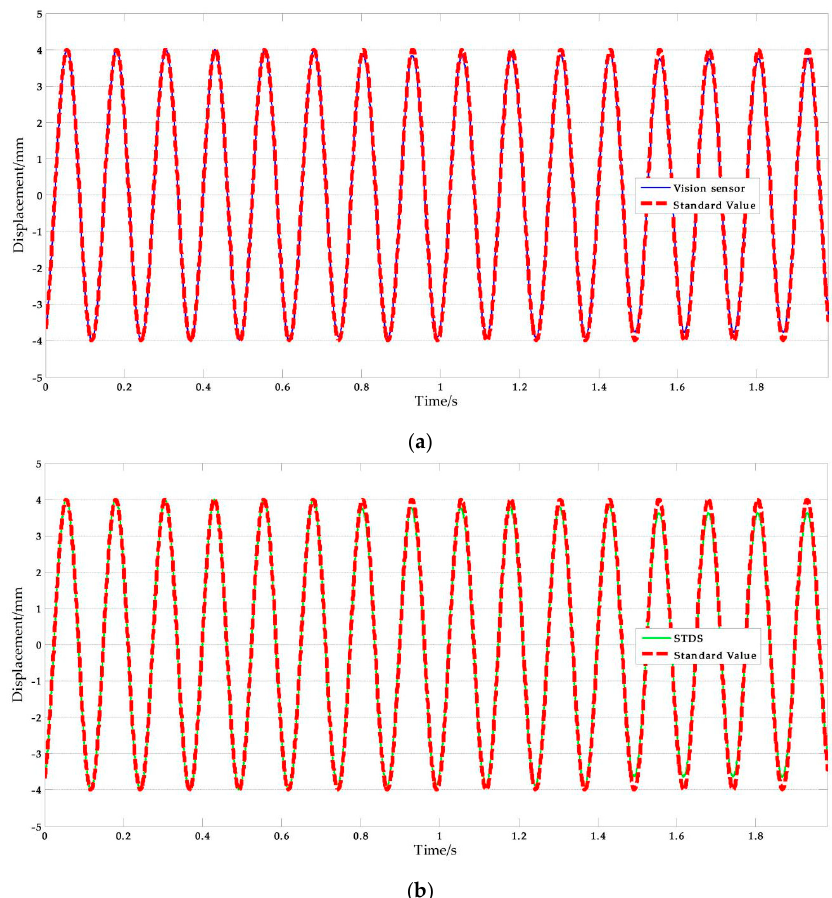
Figure 17. Measuring distance test results: ( a ) Measurement results of vision-sensor compared with standard values; ( b ) Measurement results of STDS compared with standard values. ( D = 5.0 m). Table 15. NEMSE errors analysis of measuring distance experimental results.